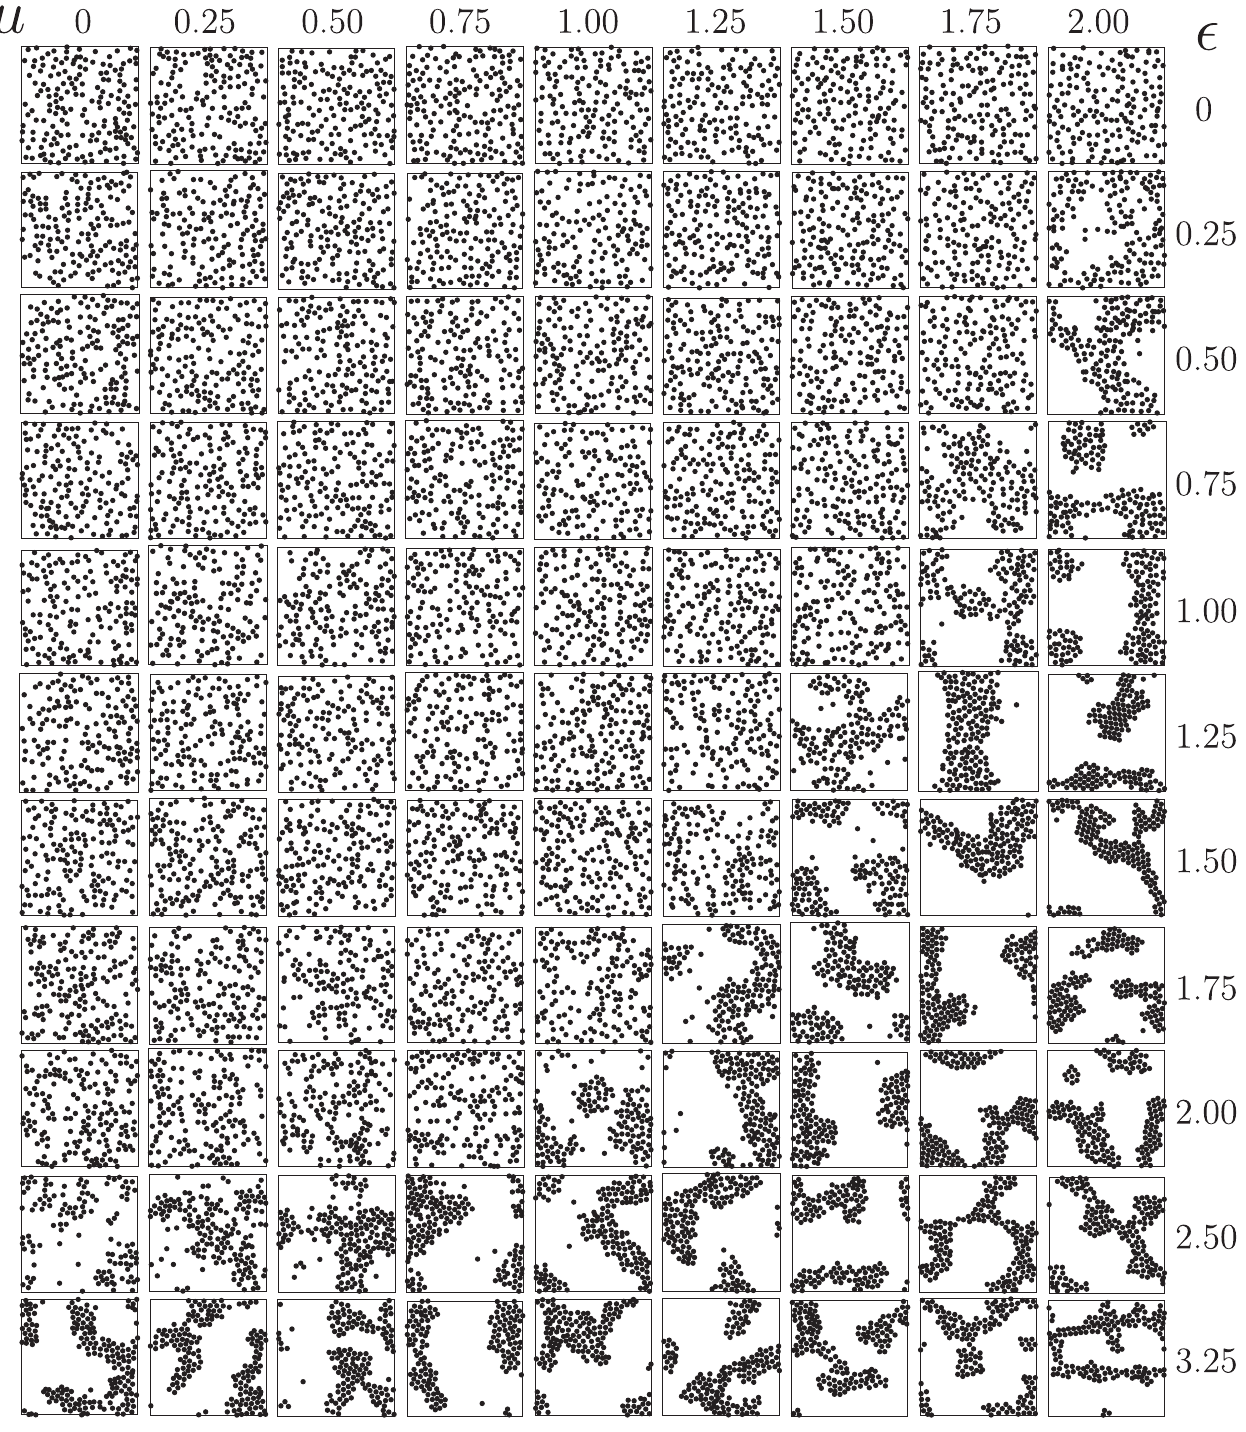
FIG. 9. Snapshots of slabs of thickness Δ z ¼ σ looking down the z axis, for ϕ ¼ 0 . 2 . From top to bottom, ϵ increases from 0 to 3.25, as labeled on the right, and μ increases from left to right, from 0 to 2, in increments of 0.25. Similarly to experiment, fluidlike and crystalline clusters percolate across the xy